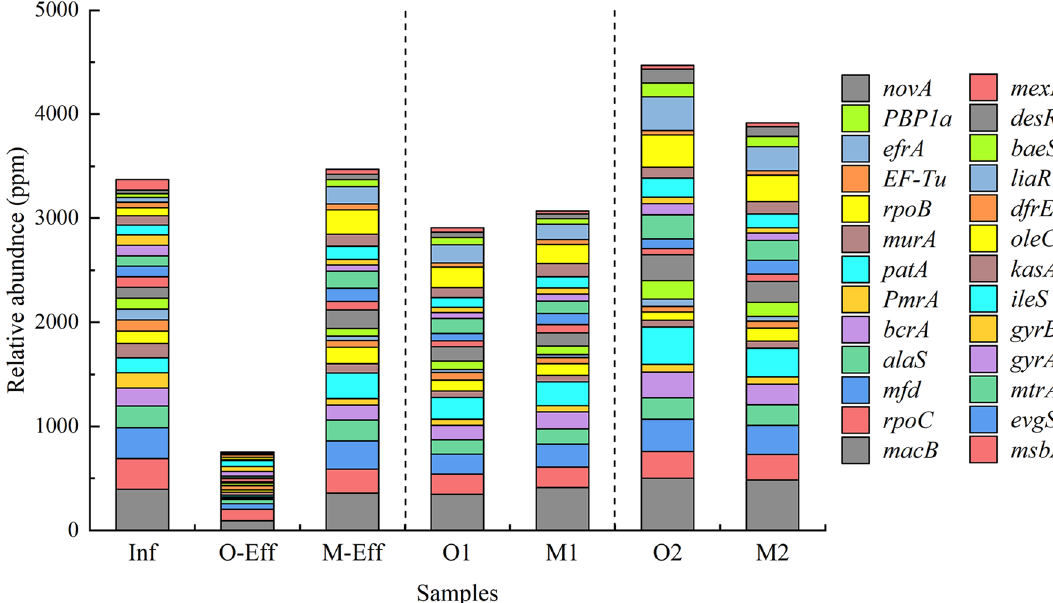
Figure 5. Distribution and relative abundance of the top 15 ARG subtypes in each sample.